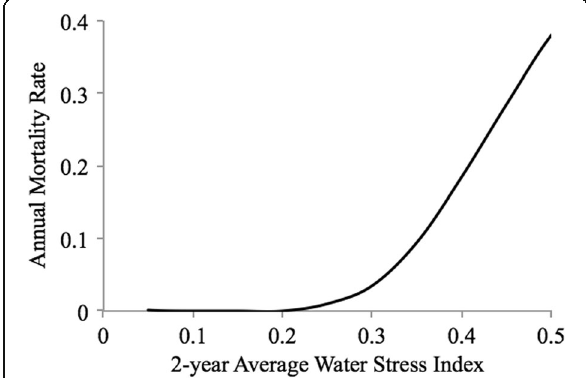
Fig. 3 Annual drought-related mortality rate in relationship to 2-year average water